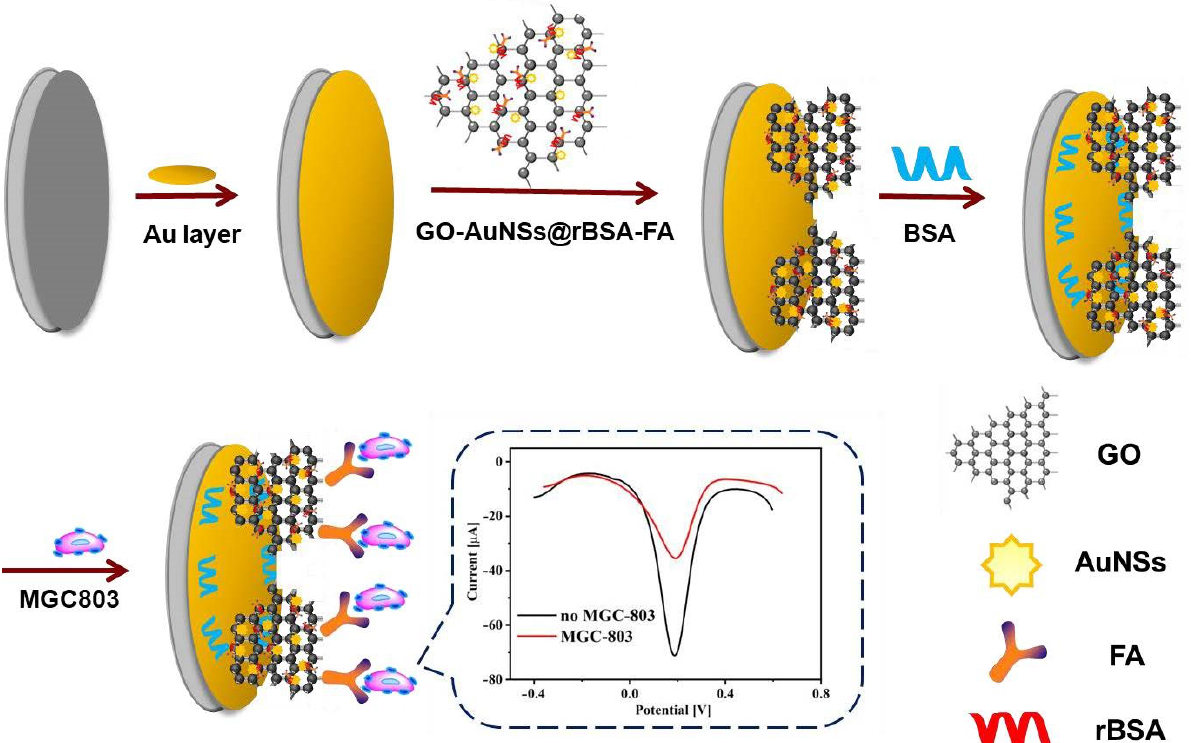
Figure 1. Schematic illustrating the fabrication procedure of the electrochemical cytosensor based on GO-AuNSs@rBSA-FA for MGC-803 cell detection.